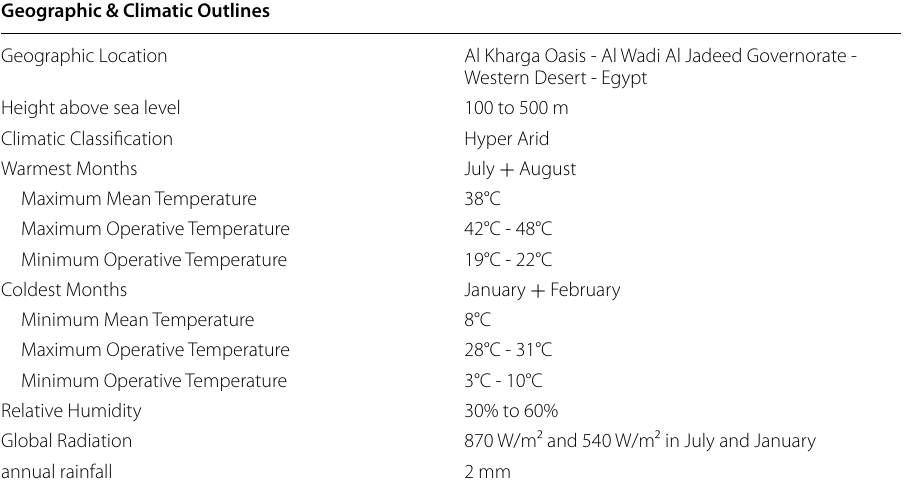
Table 1 Experimental models geographic and climatic boundaries from Bahariya Oasis weather